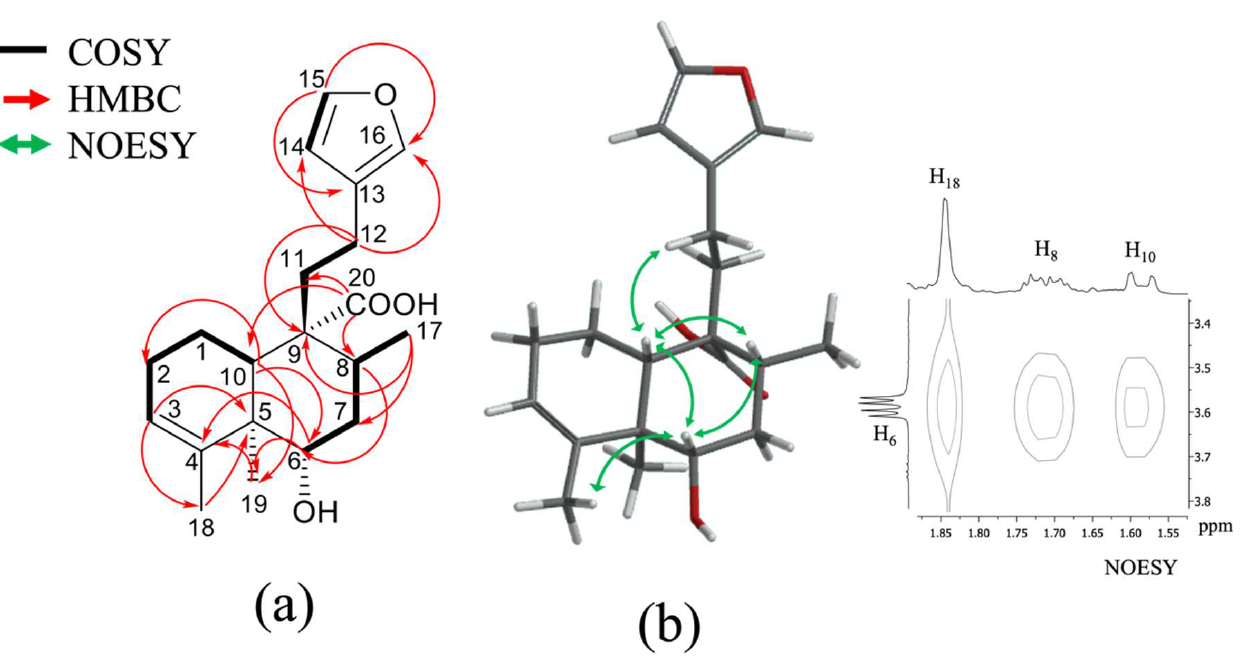
Figure 3. ( a ) 1 H- 1 H COSY and key HMBC (H—C) correlations of compound 3 ; ( b ) key NOESY correlations of compound 3 .